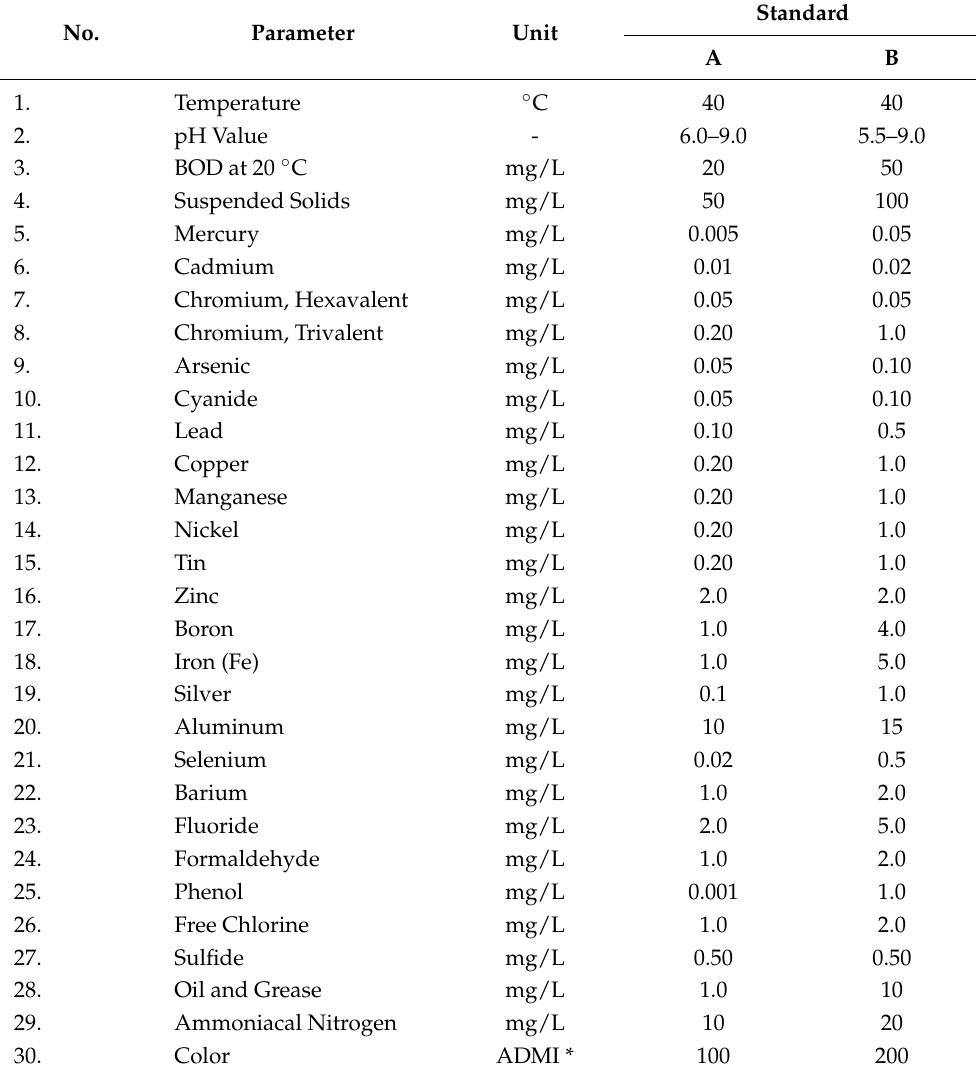
Table 4. Acceptable conditions for industrial effluents or mixed effluent discharge set by the Malaysian Ministry of Natural Resources and the Environment